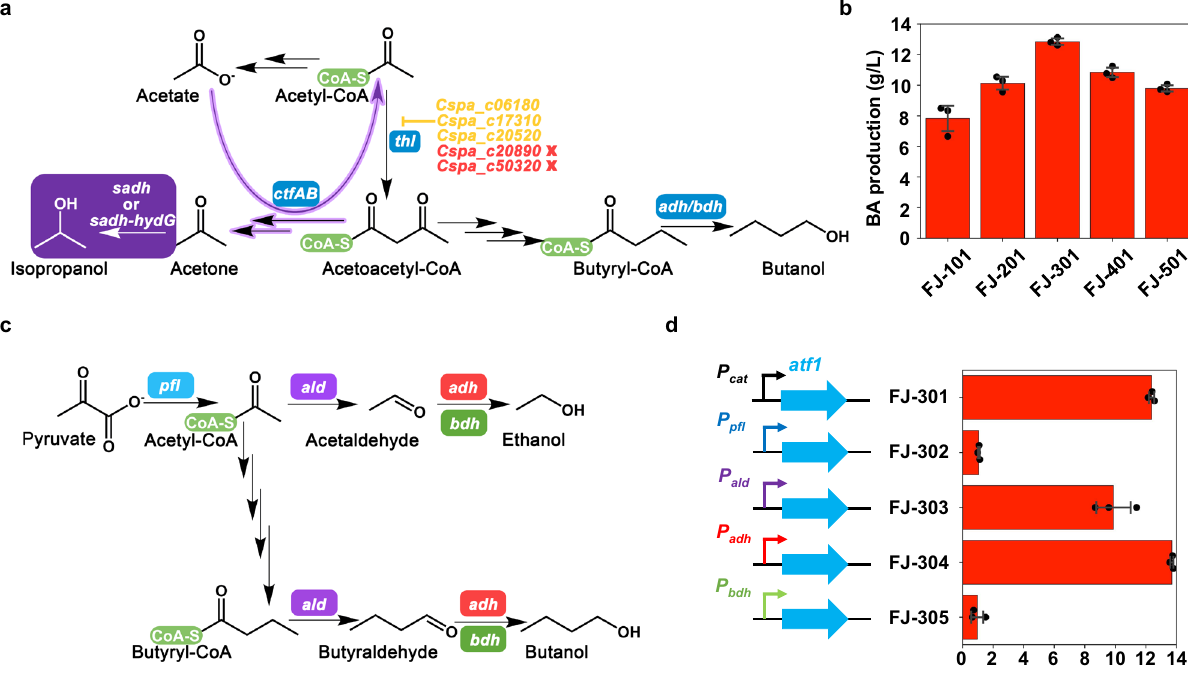
Fig. 3 Enhancing butyl acetate production through increasing the availability of acetyl-CoA and dynamically expressing the atf1 gene. a Introduction of isopropanol synthesis pathway (shaded in purple) and deletion of thiolase genes. The pathways in purple arrows represent the regeneration of acetyl-CoA. There are fi ve annotated genes encoding thiolase in C. saccharoperbutylacetonicum , only two (in red) of which could be deleted (see Supplementary Note 2). b The fermentation results for butyl acetate (BA) production with various mutant strains corresponding to the genetic manipulations in ( a ). Data are presented as mean values ± SD ( n = 3). c Four promoters associated with the biosynthesis of acetyl-CoA or alcohols in the pathway were selected to drive the expression of atf1 . d The fermentation results for BA production with various mutant strains in which different promoters were used to drive the expression of atf1 as illustrated in ( c ). Data are presented as mean values ± SD ( n = 3). Key genes in the pathway: adh alcohol dehydrogenase, bdh butanol dehydrogenase, ctfAB CoA transferase, sadh secondary alcohol dehydrogenase, hydG putative electron transfer protein, p fl pyruvate formate lyase, ald aldehyde dehydrogenase. Source data underlying Fig. 3b and d are provided as a Source Data fi